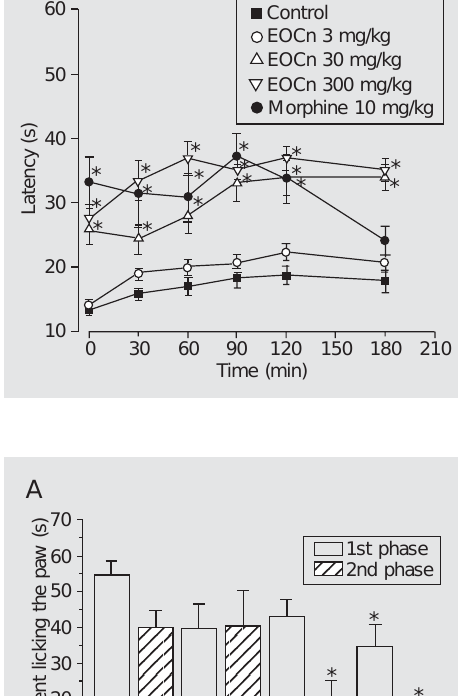
Figure 2. Effect of the essential oil of Croton nepetaefolius (EOCn) on the nociceptor stimu- lation by intraplantar injection of formalin (1%). Data are reported as means ± SEM, with the SEM indicated by vertical bars. Mor- phine (Mor) was administered subcutaneously and EOCn ( per os ) 30 and 60 min prior to nox- ious stimulation, respectively. Naloxone (Nal) was adminis- tered intraperitoneally 10 min prior to morphine or EOCn ad- ministration. *P (cid:1) 0.05 compared to control, **P (cid:1) 0.05 compared to morphine alone, and + P (cid:1) 0.05 compared to control but not in the presence of naloxone (ANOVA, Bonferroni t